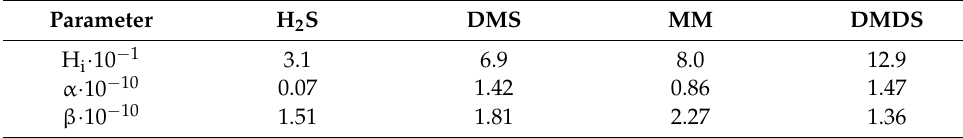
Table 2. Parameters α and β for the two-parameter model.